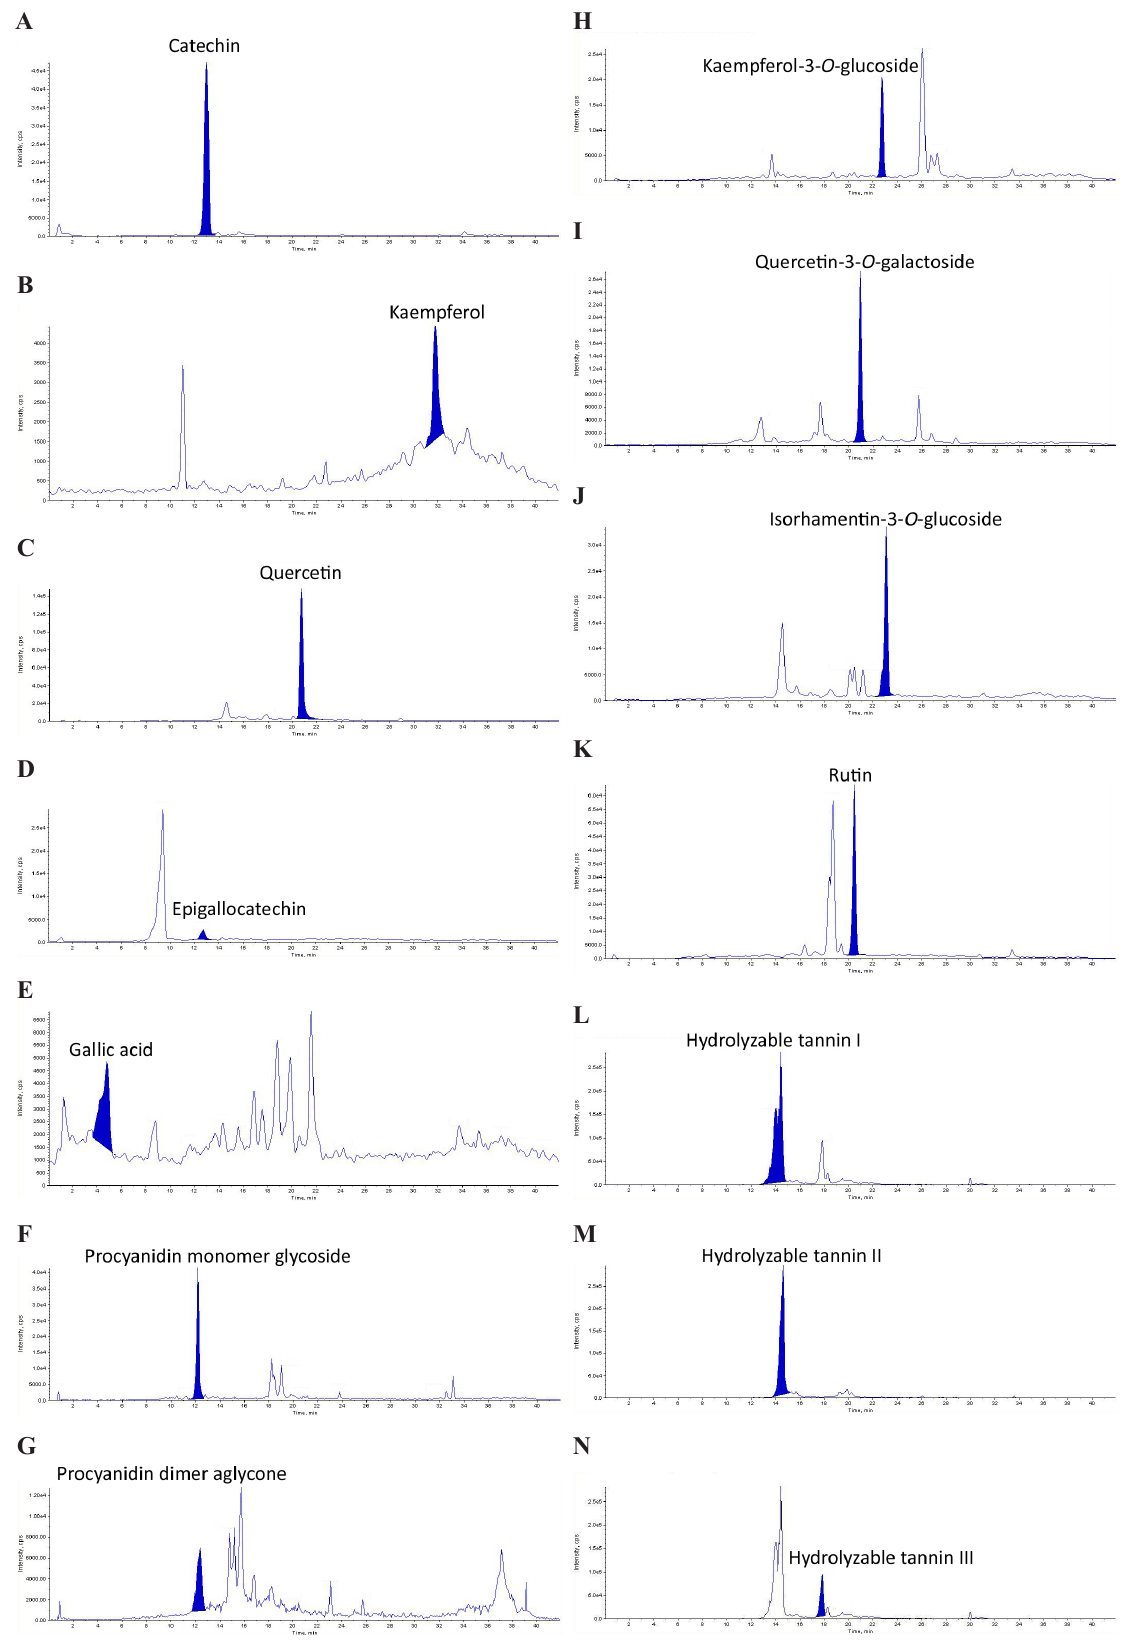
Fig. 4. MS traces of a leaf sample of cv ‘Ljubitelskaja’ for A) catechin (m/z 289.1, rt 13.0), B) kaempferol (m/z 285.1, rt 31.7), C) quercetin (m/z 301.2, rt 20.7), D) epigallocatechin (m/z 305.2, rt 12.7), E) kaempferol-3- O -glucoside (m/z 447.3, rt 22.7), F) quercetin-3- O - galactoside (m/z 463.4, rt 20.9), G) isorhamnetin-3- O -glucoside (m/z 477.4, rt 23.0), H) rutin (m/z 609.5, rt 20.4), I) gallic acid (m/z 169.1, rt 4.9), J) procyanidin monomer glycoside (m/z 451.2, rt 12.2), K) procyanidin dimer aglycone (m/z 577.2, rt 12.4), L) hydrolyzable tannin I (m/z 935.5, rt 14.2, double peak), M) hydrolyzable tannin II (m/z 953.5, rt 14.6) and N) hydrolyzable tannin III (m/z 935.5, rt